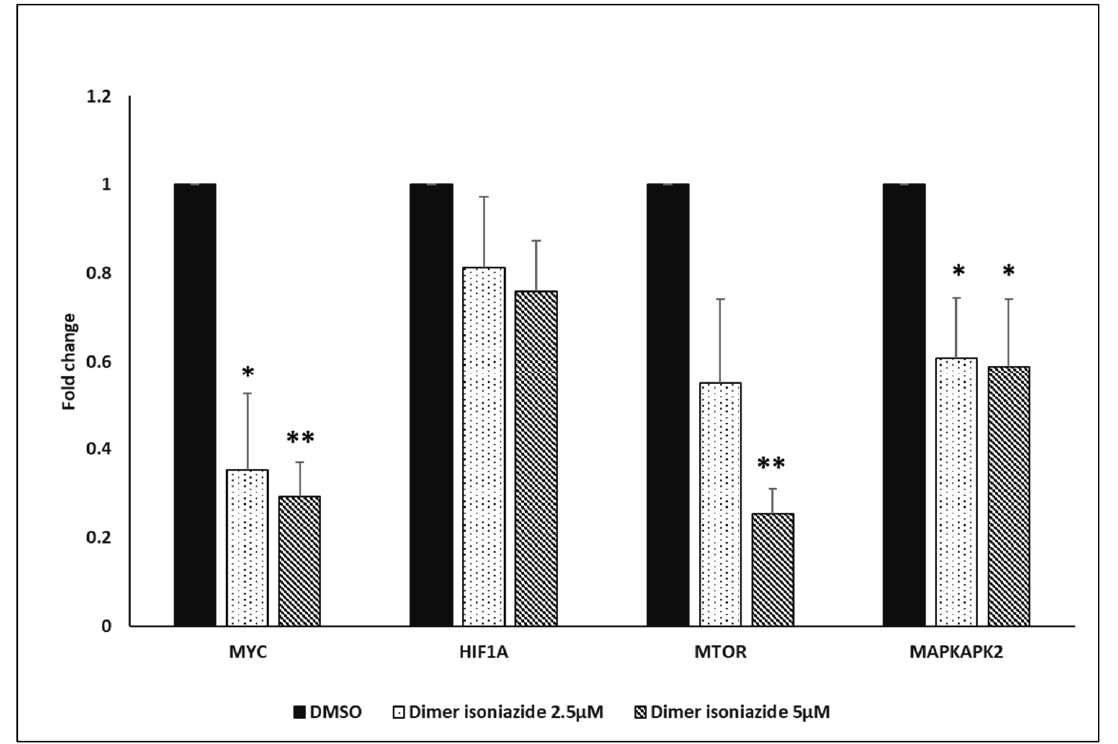
Figure 6. qPCR analysis. Treatment of CCRF-CEM cells with 2.5 and 5 µ M of artemisinin dimer signi fi cantly decreased the expression of MYC , MTOR , and MAPKAPK2 genes, while no sig- ni fi cant inhibition was observed for HIF1A . Statistical signi fi cance in comparison to control (DMSO) is designated at a level of * p ≤ 0.05 and ** p ≤ 0.01.